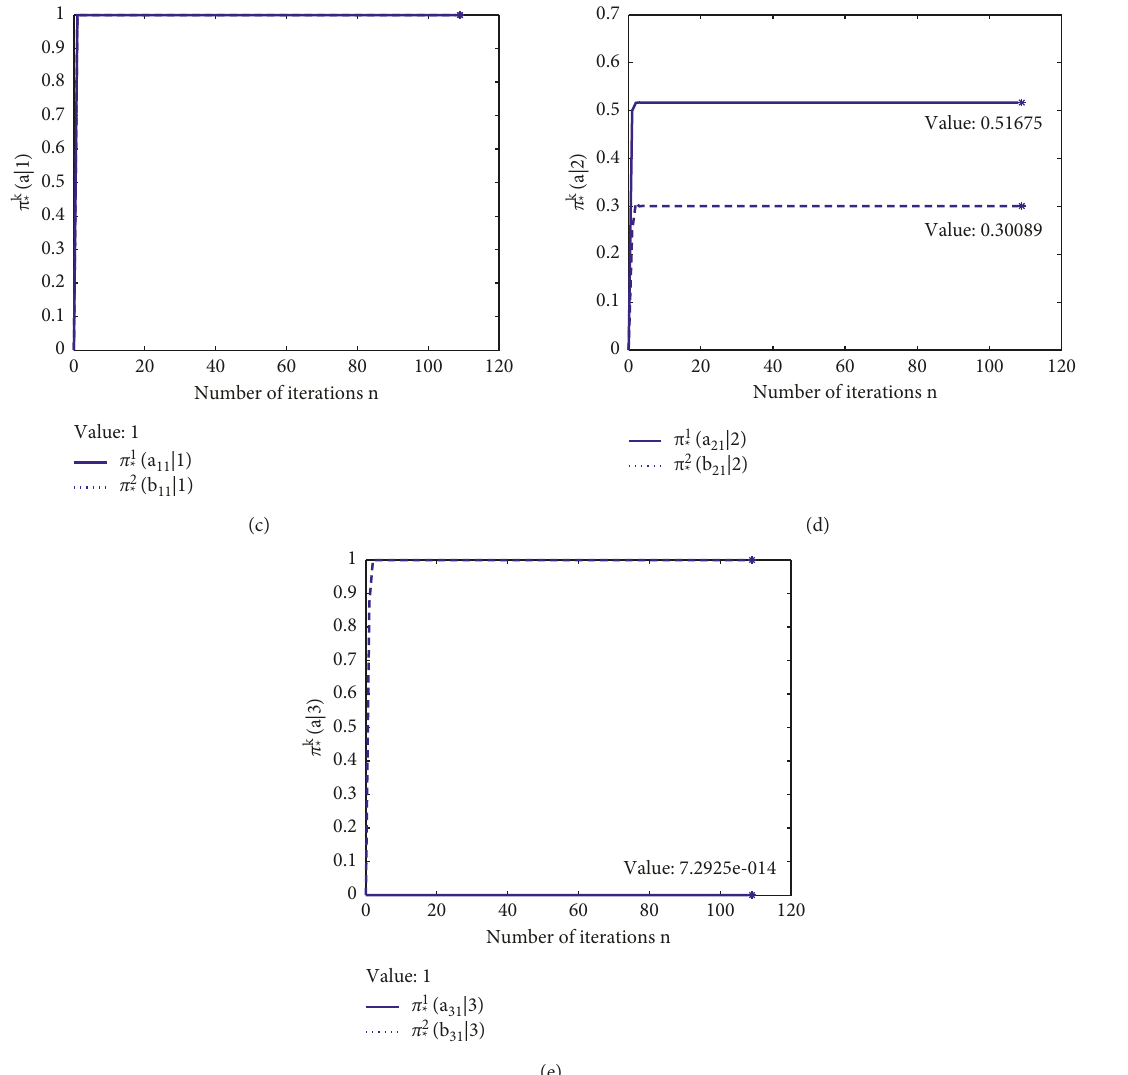
Figure 2: The case of varying discount factors with α ( i ) ≡ α � 0 . 9 ,i � 1 , 2 , 3. (a) Error of iterative values. (b) Optimal values. (c) Optimal policy pairs in i � 1. (d) Optimal policy pairs in i � 2. (e) Optimal policy pairs in i �